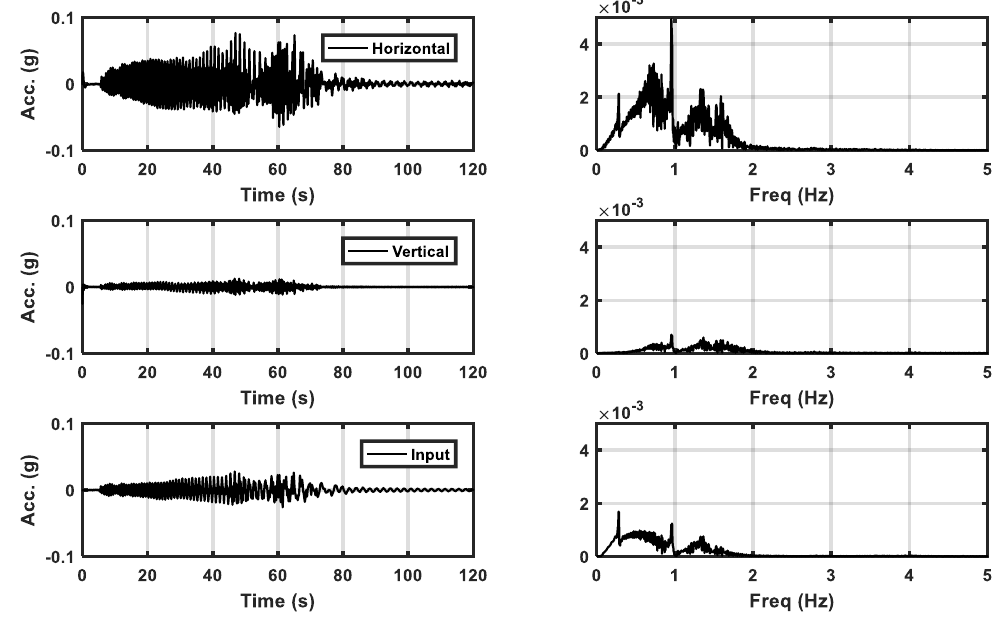
Figure 13. Structural response to a sine sweep motion.